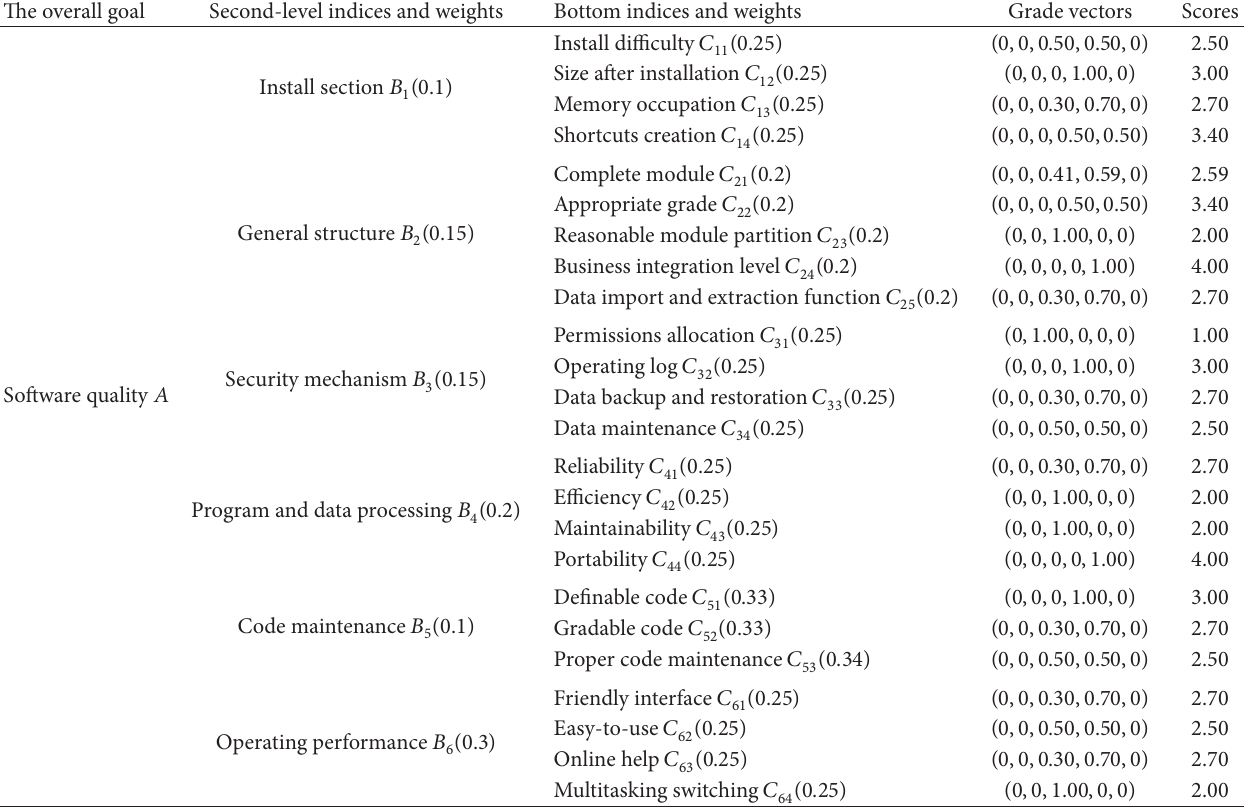
Table 2: Evaluation system of software quality.